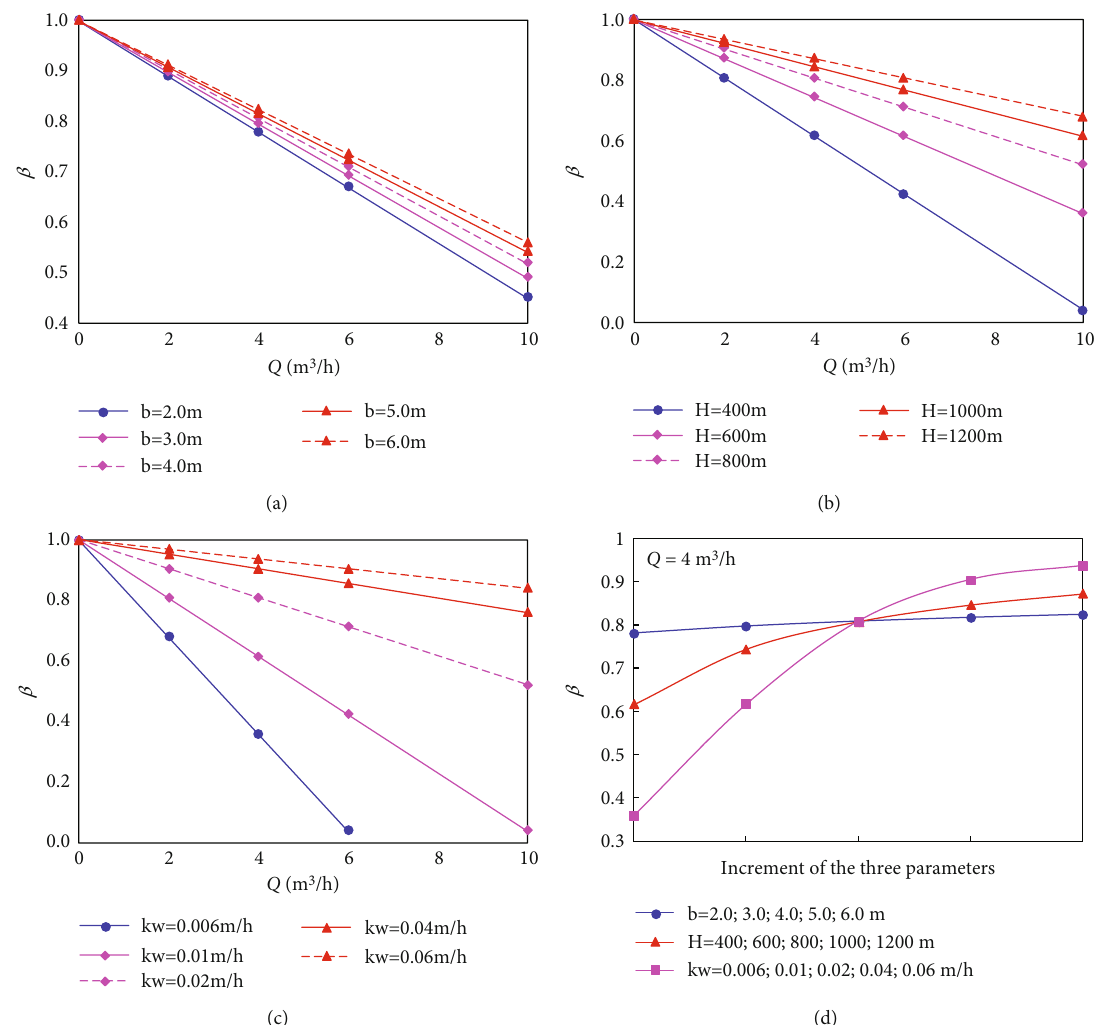
Figure 4: Evolution of water pressure reduction coe ffi cient with shaft lining with water seepage fl ow: (a) variation of b ; (b) variation of H ; (c) variation of k ; (d) comparison of three w